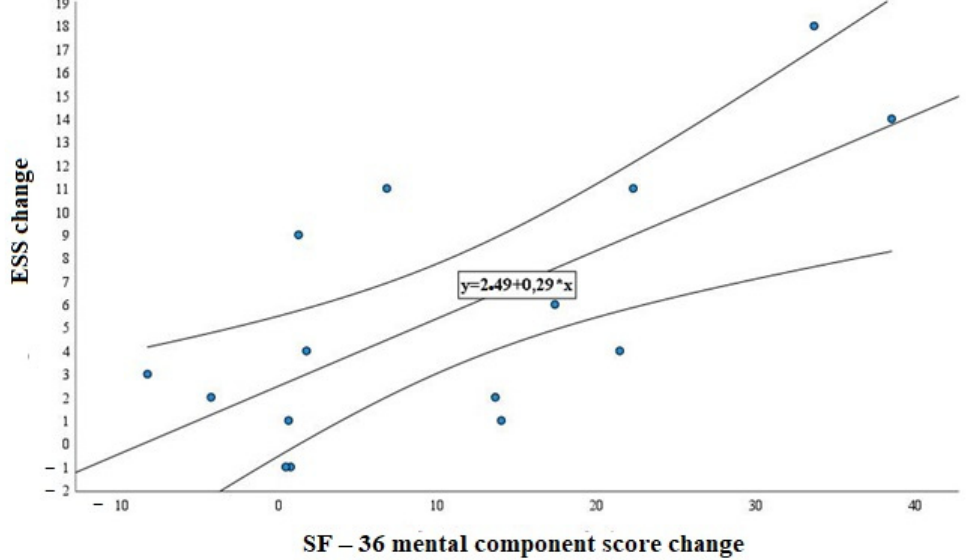
Figure 2. Scatter plot showing the relationship between improvements in the SF-36 mental component score with CPAP treatment and the Epworth Sleepiness Scale (ESS).